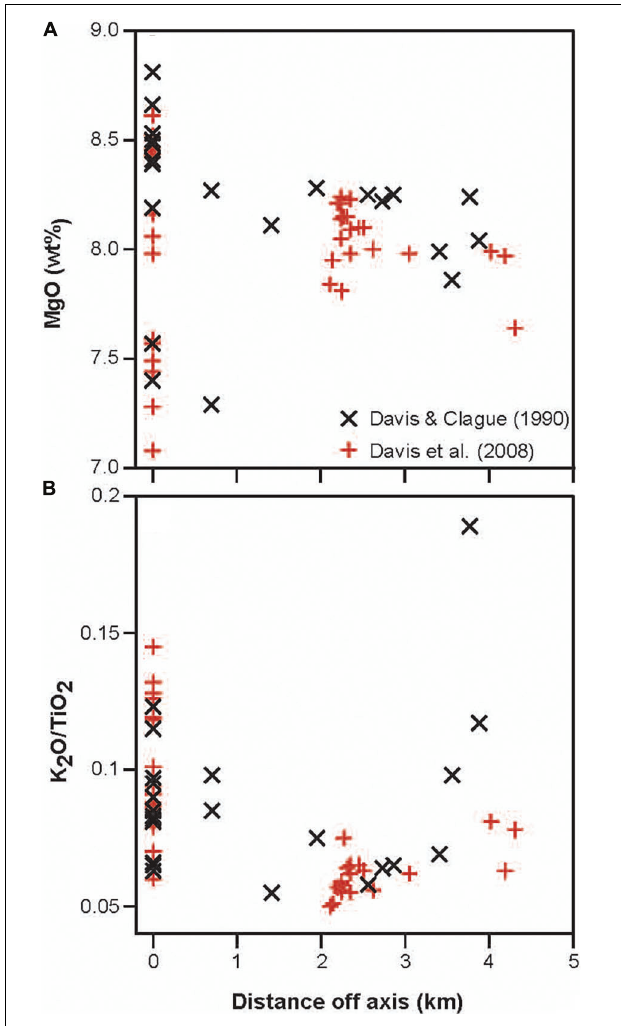
FIGURE 7 | Geochemistry of samples from east side of axial valley projected onto cross section in Figure 6C . Distance is from the center of the axial graben. Dredge samples from Davis and Clague (1990) are plotted in the middle of the dredge track. (A) MgO vs. distance from center of axis. (B) K 2 O/TiO 2 vs. distance from center of